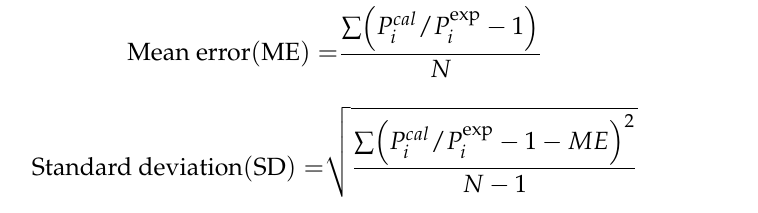
Figure 5. The influence of diameter–thickness ratio on burst pressure.